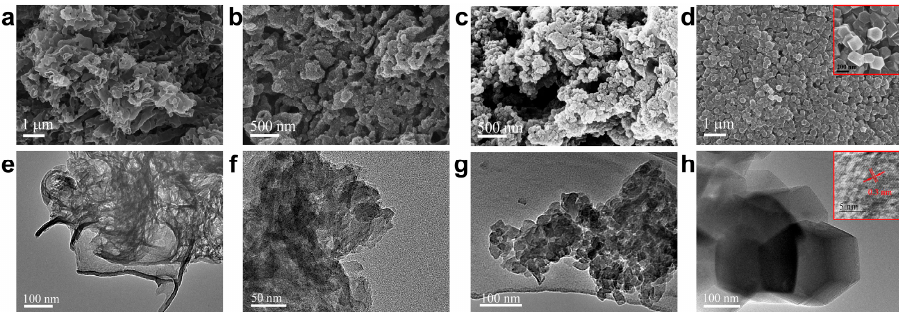
Figure 4. Morphologies of the g-C 3 N 4 samples. ( a – d ): SEM images of melon, PHI, PHI/PTI and PTI. The inset in ( d ) is the SEM image of PTI while at larger magni fi cation. ( e – h ): Bright- fi eld TEM images of melon, PHI, PHI/PTI and PTI samples. The inset in ( h ) is the HRTEM image of PTI.